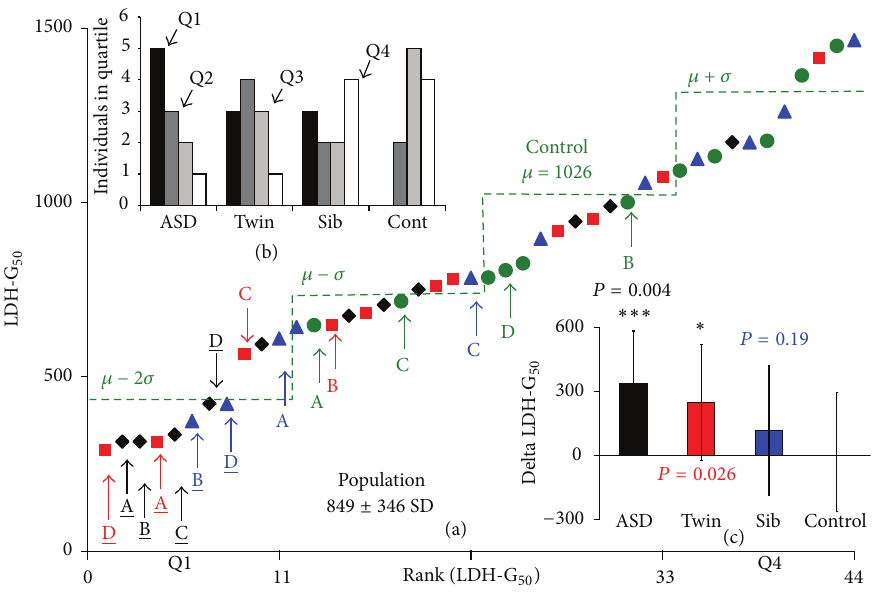
Figure 2: (a) shows the thimerosal concentration that induced a 50% growth inhibition at day 5, measured by the LDH method (LDH- G 50 ). In (a) the color-coded cells are ranked in terms of sensitivity to thimerosal. Four family groups are shown whose autistic B-cell LDH-G 50 ’s fall greater than 2 standard deviations below the mean: A, B, C, and D. Underlined letters denote those cells believed to have a heightened sensitivity to thimerosal (i.e., those falling outside two standard deviations of the control population). The distribution of the control population is indicated by the green lines showing mean + SD, mean, mean – SD, and mean − 2SD. Distribution of Cells Types. In the upper insert, (b) we show the distribution of the four cells types: ASD, unaffected Twin, unaffected Sibling, and external age/sex matched control, in the four quartiles of the ranked distribution. It is noteworthy that the ASD derived cells are more clustered in the left hand side of the distribution and the external controls are distributed to the right hand side. Test for Systemic Errors. In the second insert, (c) we show that there is no systemic correlation between low LDH-G 50 ’s in cells drawn from families from an ASD background and their respective controls. The graph in (c) shows the average and standard deviation of the difference between the appropriate age/sex matched control and each of the ASD familial LDH-G 50 . The positive values indicate that cells from the affected families are more sensitive than the external controls. The 𝑃 values indicate the results from a one-tailed t -test, 𝑛 = 11 , with, ( ∗ ) indicating < 0.05, and ( ∗∗∗ ) indicating <